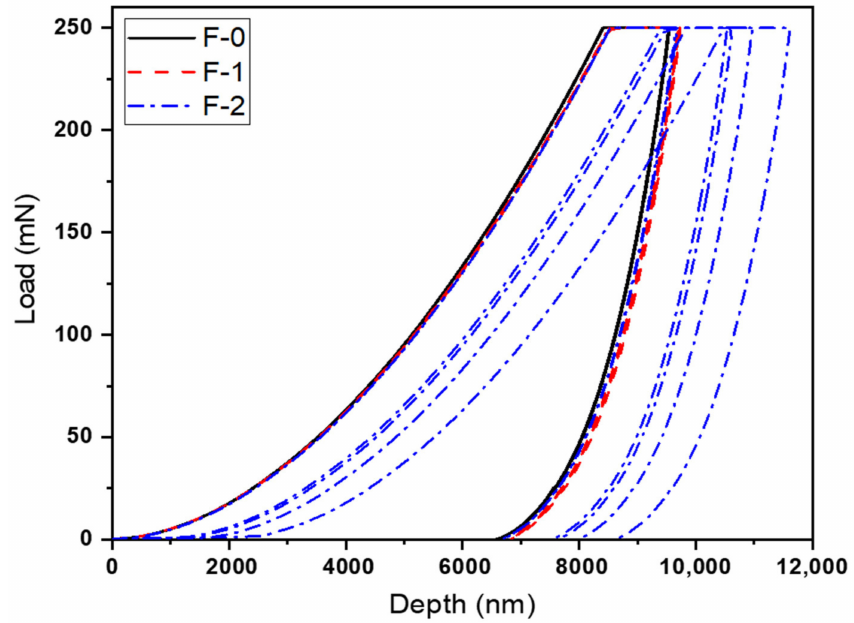
Figure 7. Load vs. depth curve for coatings prepared with PA-3282 at different